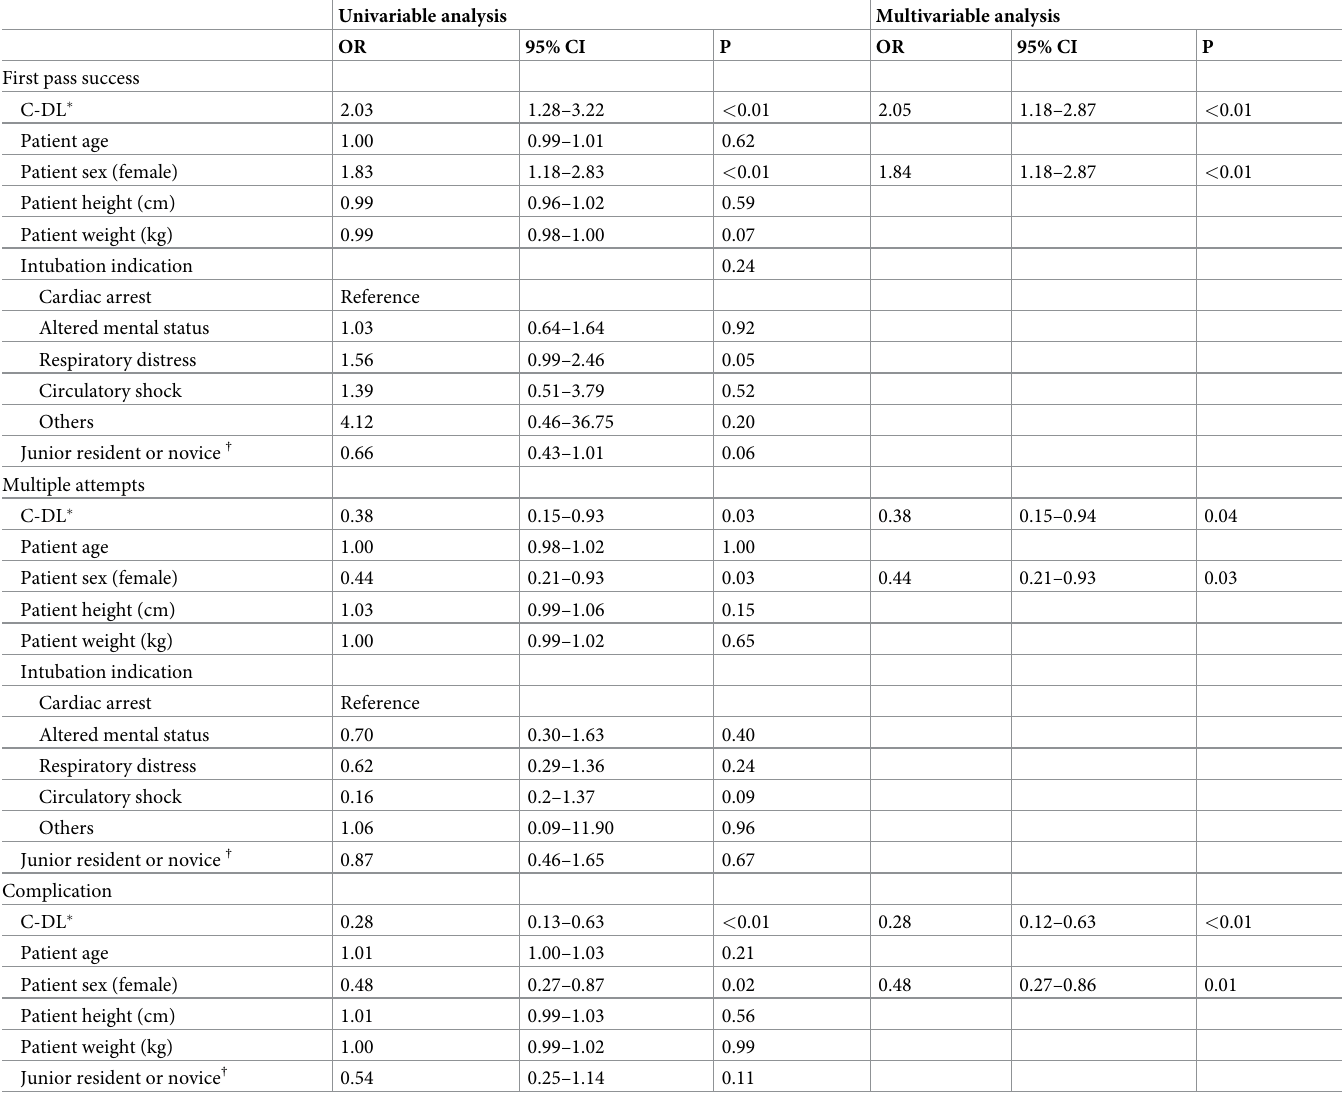
Table 3. Relationships between outcomes and C-DL among 591 propensity-matched